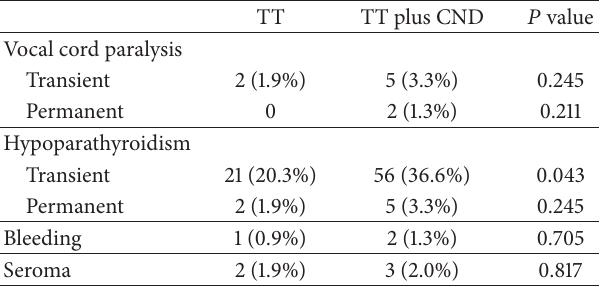
Table 2: Comparison of complication rates.